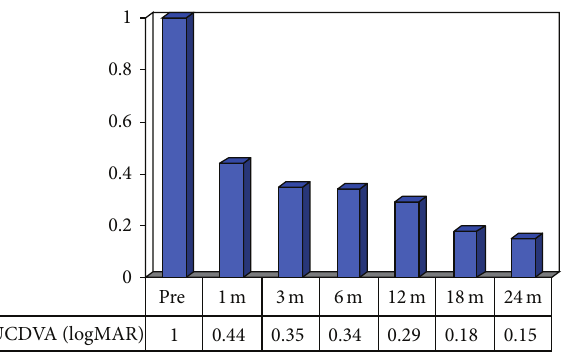
Figure 4: UCDVA results.